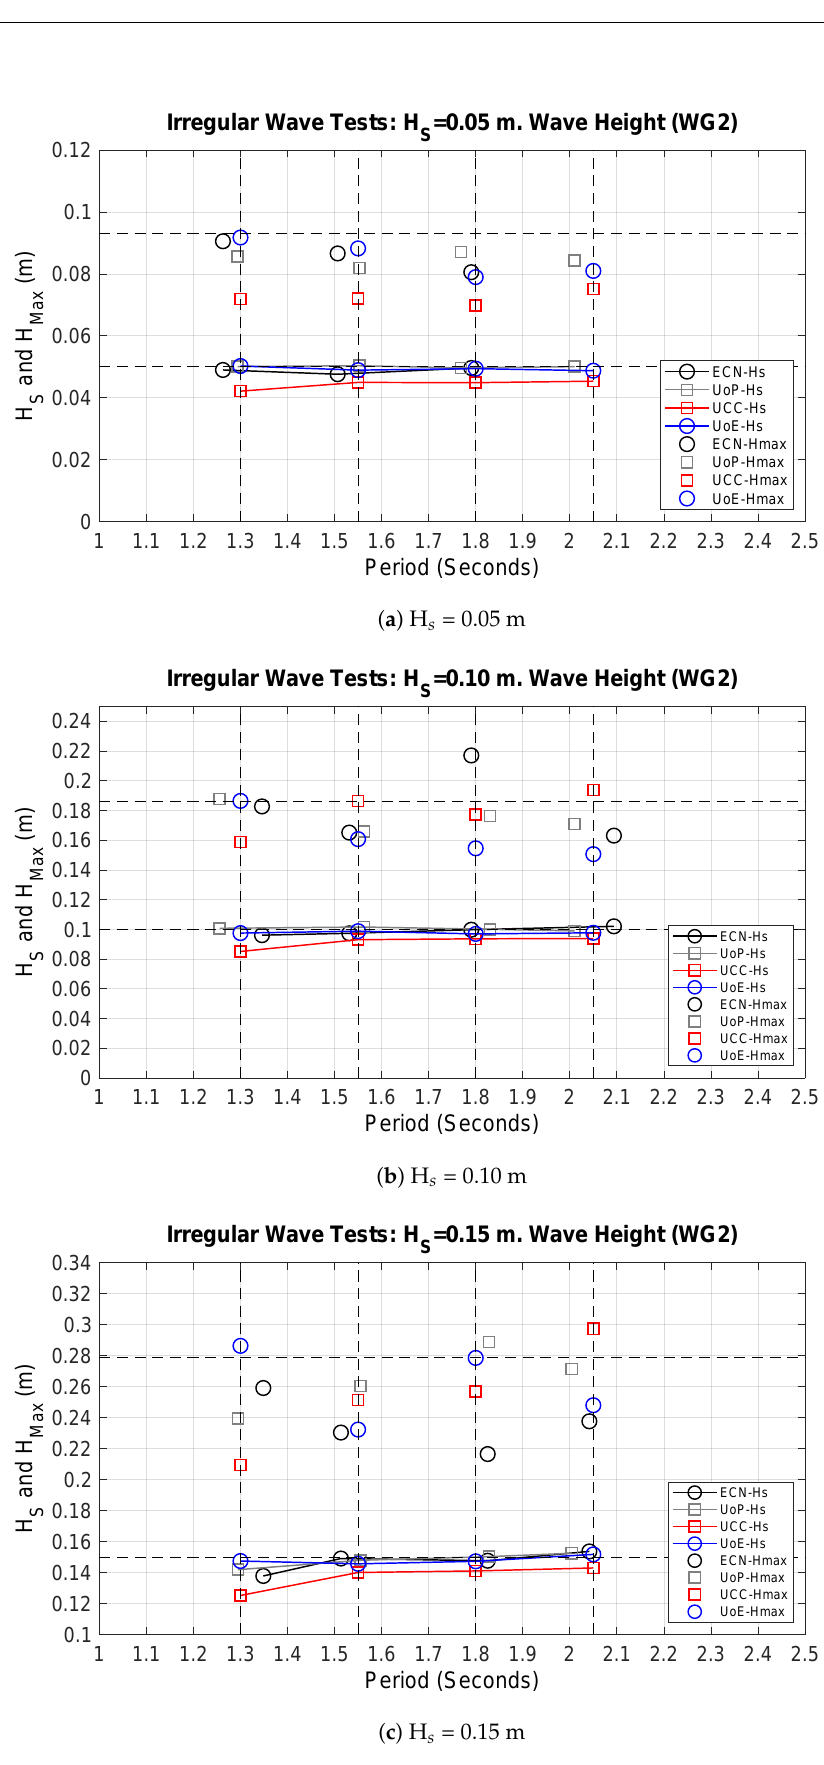
Figure 5. Significant and maximum wave heights measured across all